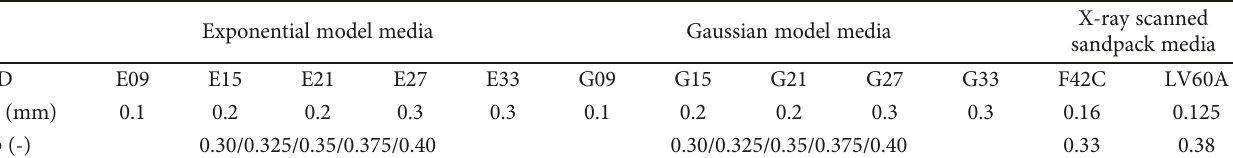
Table 1: Characteristics of generated and scanned porous media used for numerical simulations.